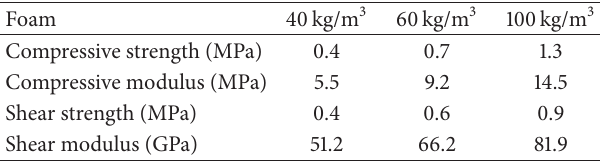
Table 3: Material properties of